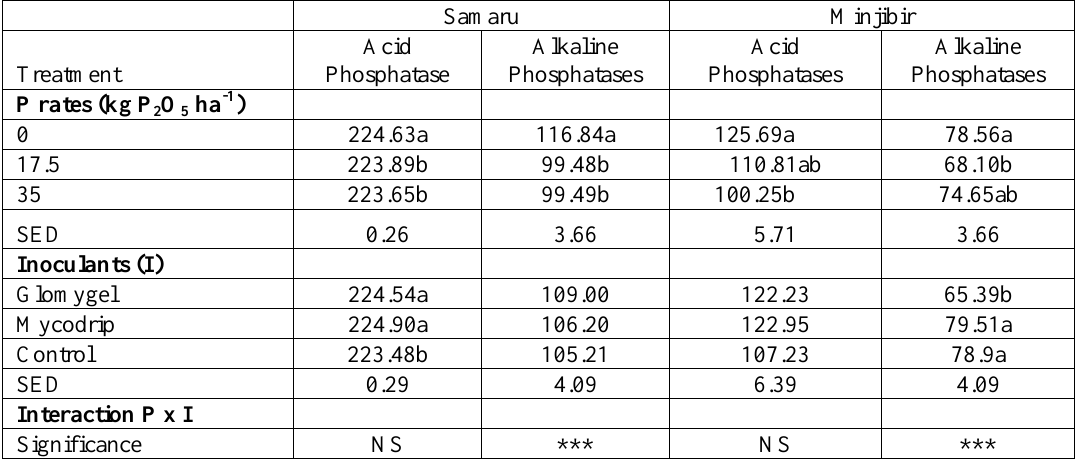
Table 1. Effects of P fertilization (P) and Mycorrhizal inoculation (I) on Activity